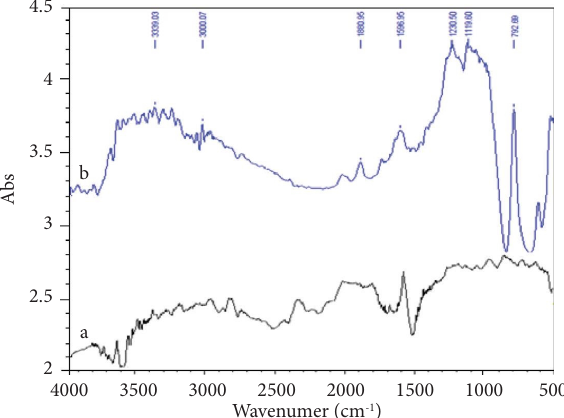
Figure 4: FT-IR spectra of (a) DA and (b)